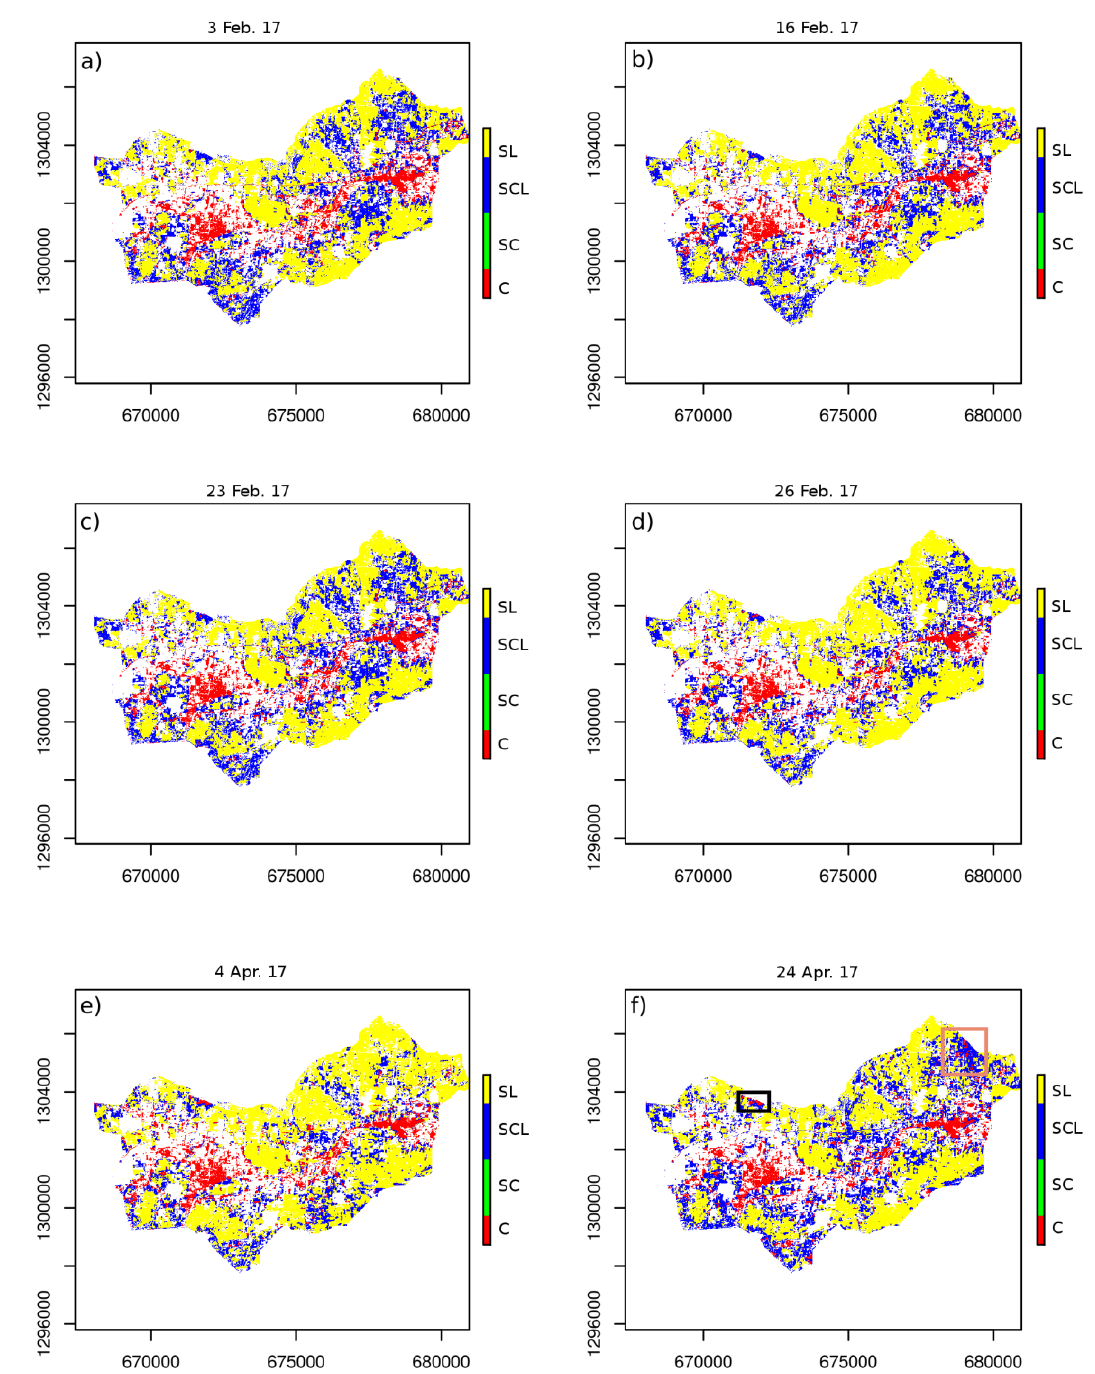
Figure 5. Maps of the most frequent textural class among the 100 estimations obtained from the image acquired on ( a ) 3 Feb. 2017, ( b ) 16 Feb. 2017, ( c ) 23 Feb. 2017, ( d ) 26 Feb. 2017, ( e ) 4 Apr. 2017 and ( f ) 24 Apr. 2017. The white areas correspond to the masked mixed